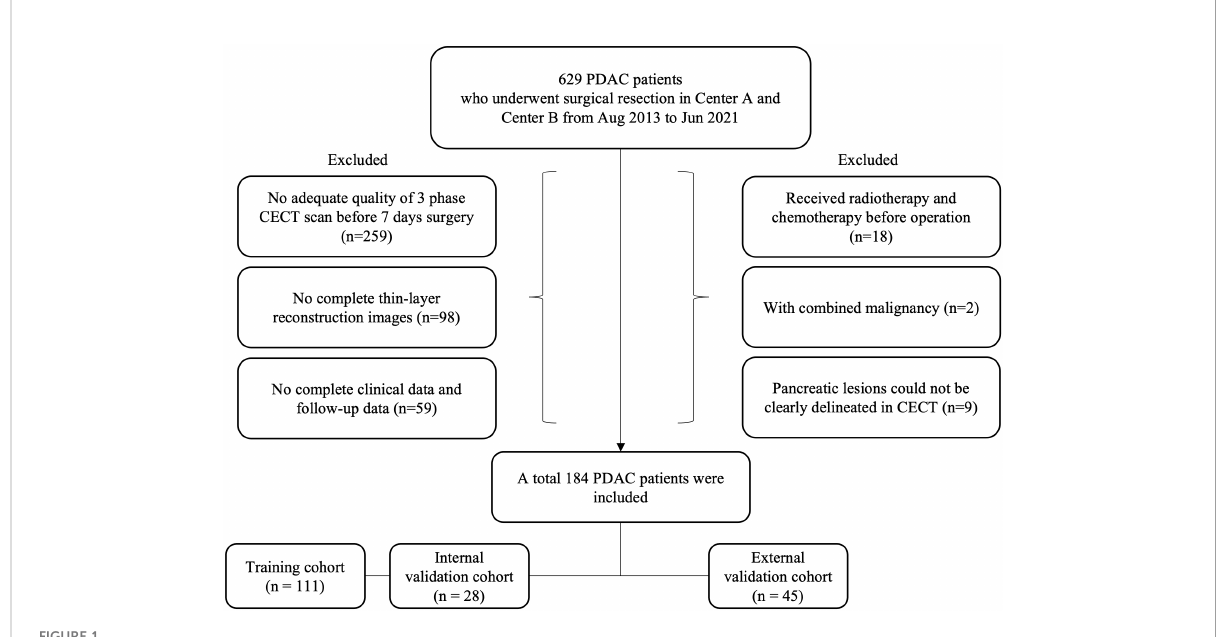
FIGURE 1 Flow chart visualizing the patient selection